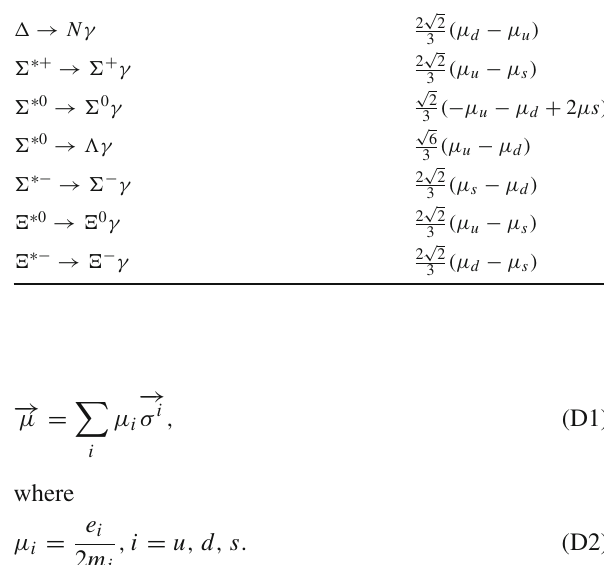
Table 15 Decuplet to octet baryon transition magnetic moments in quark model Process